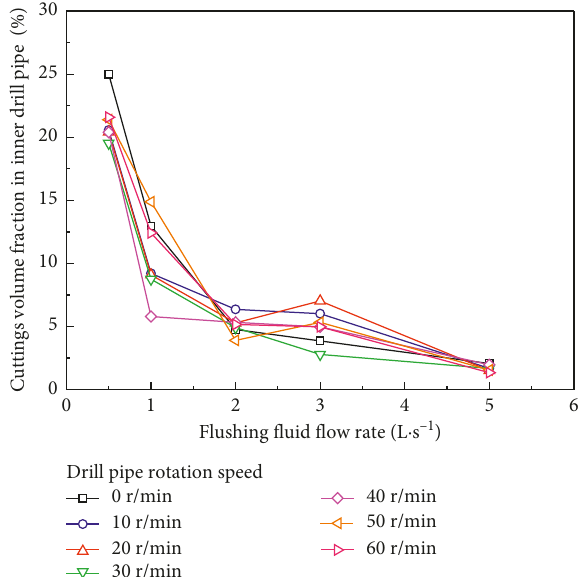
Figure 12: Experimental results of dual drill pipes reverse